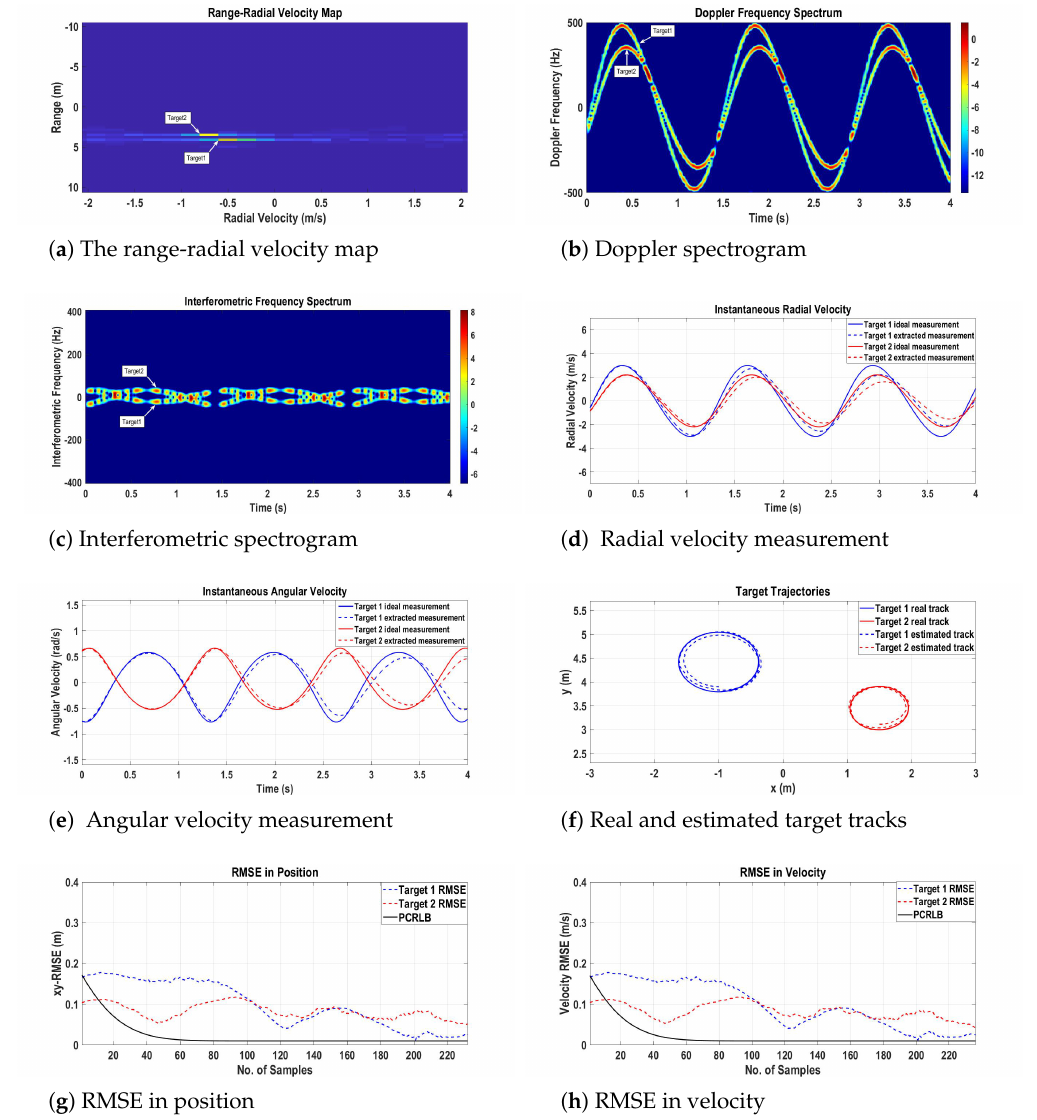
Figure 8. Scenario 2: Two non-maneuvering targets with circular